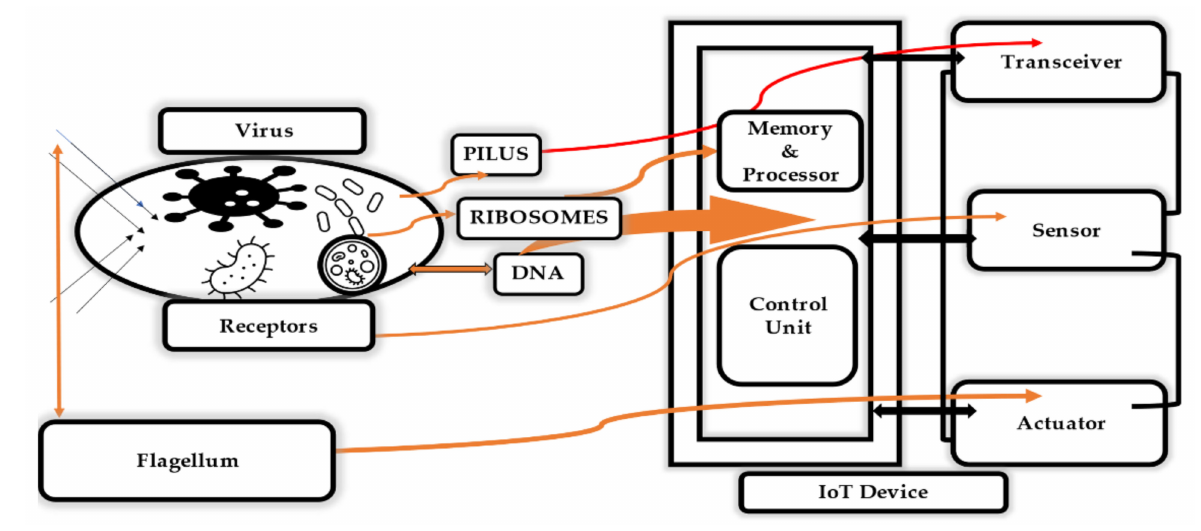
Figure 6. Virus as IoT